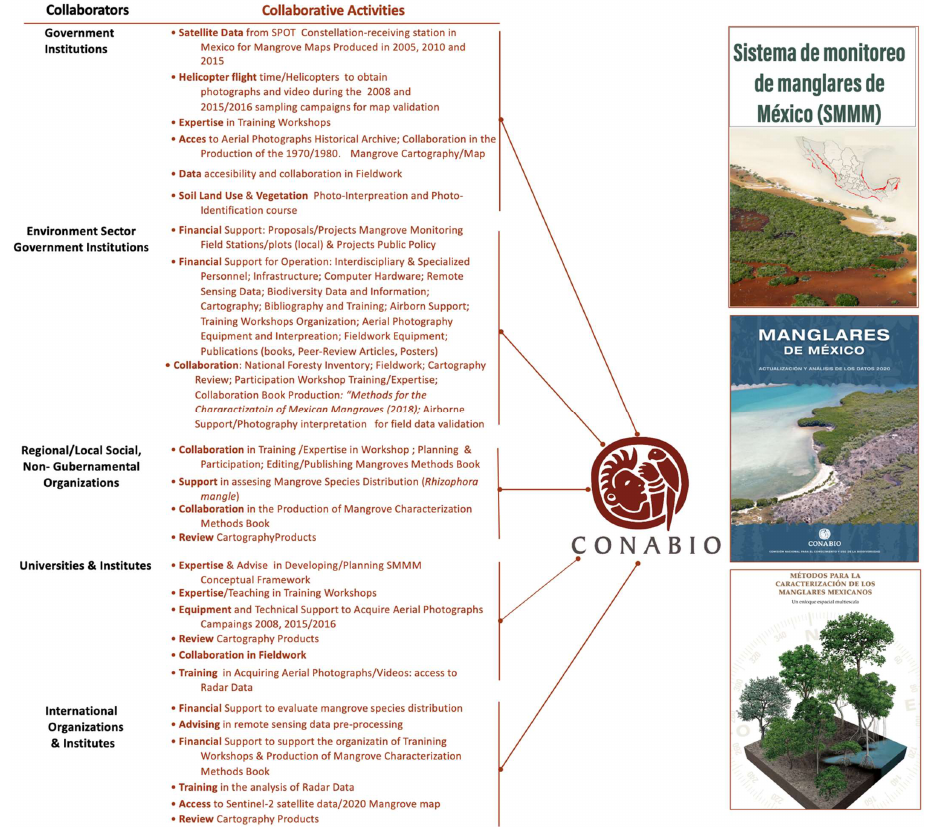
Figure 6. List and interactions among different collaborators in the Mexico’s SMMM showing key activities developed and implemented from 2005–2020. Thus, the SMMM is an iterative process in the assessments of mangrove natural re- sources that is centered in the evaluation of spatial trends (Figure 5). Based on funding availability and logistic constraints, this system attempts to maintain a constant flow of data/information across the assessment, characterization, collaboration, and social de- mands/requirements that are re-evaluated according to new priorities and needs.